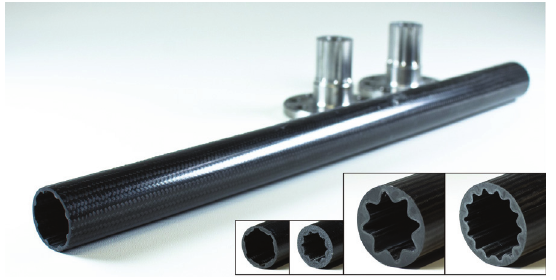
Figure 9 Different prototypic profiled shaft shapes.